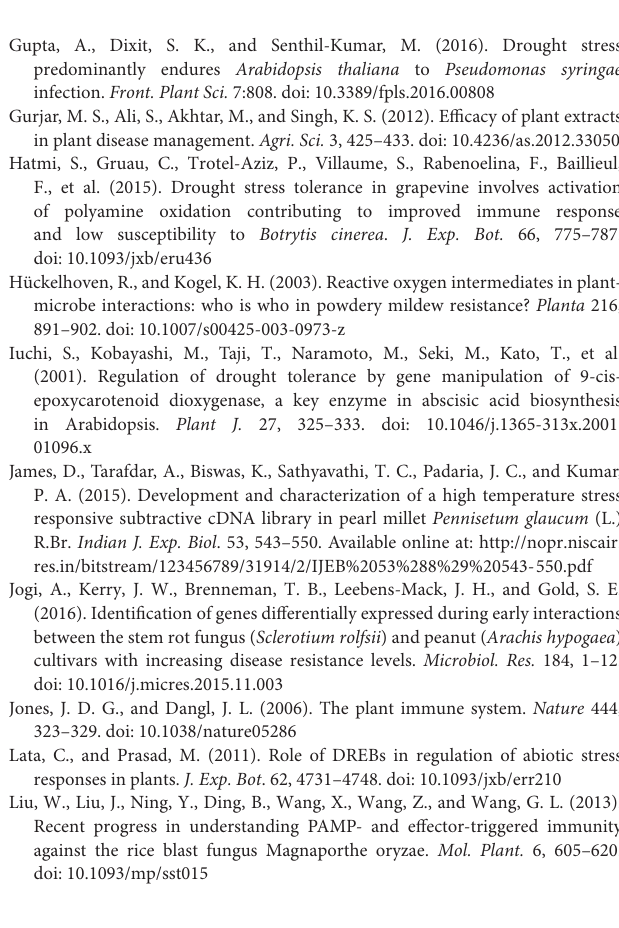
Table S2 | Collar rot disease incidence in chickpea